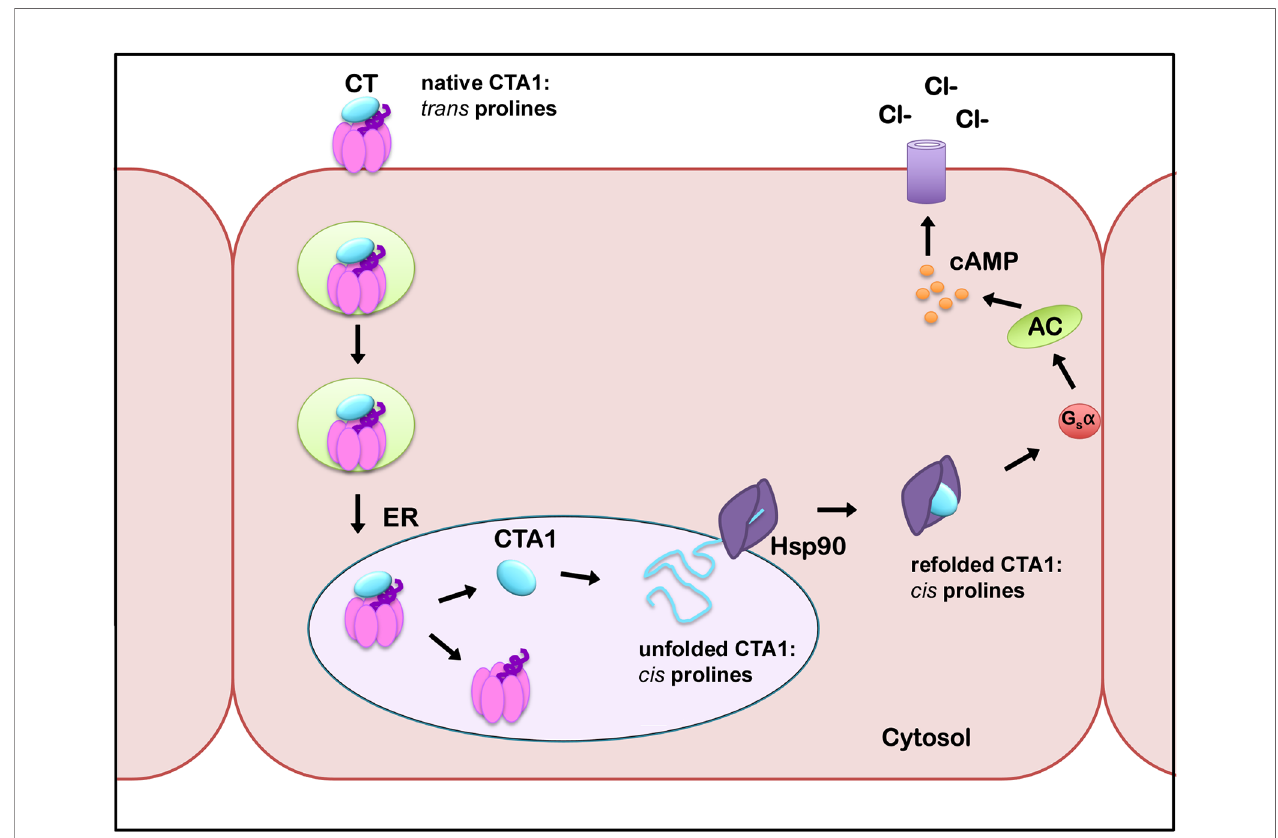
FIGURE 5 | A model for the impact of proline cis / trans isomerization on CTA1-Hsp90 interactions. CTA1 enters the ER as a folded component of intact CT, with trans prolines in the RPPDEI motif. Separation of CTA1 from the rest of the toxin leads to its spontaneous unfolding and a hypothesized shift in its RPPDEI proline residues to the cis conformation. Those cis prolines are recognized by Hsp90 at the cytosolic face of the ER membrane after ERAD initiates the process of toxin translocation. Hsp90 then couples CTA1 refolding with CTA1 extraction from the ER translocon pore, but we predict refolding does not convert the RPPDEI prolines back to the trans state. Hsp90 thus remains in a stable complex with refolded CTA1 and its cis proline residues. Continued association of Hsp90 with CTA1 allows the otherwise unstable toxin to maintain its enzymatic activity in the host cytosol. AC, adenylate